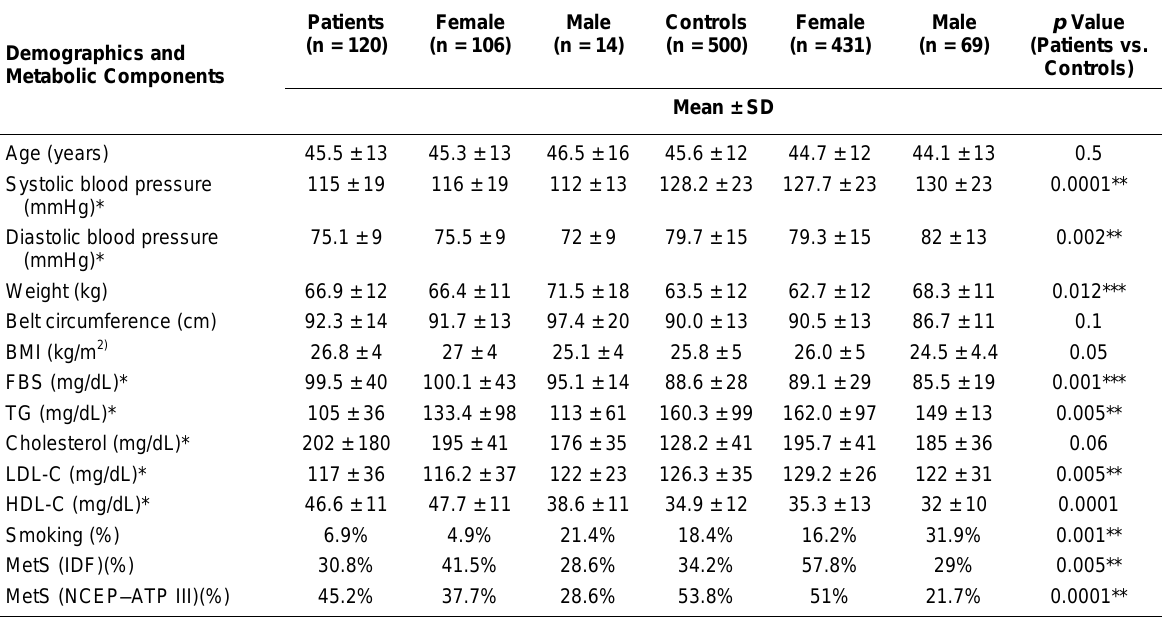
Demographic Data of Patient and Control